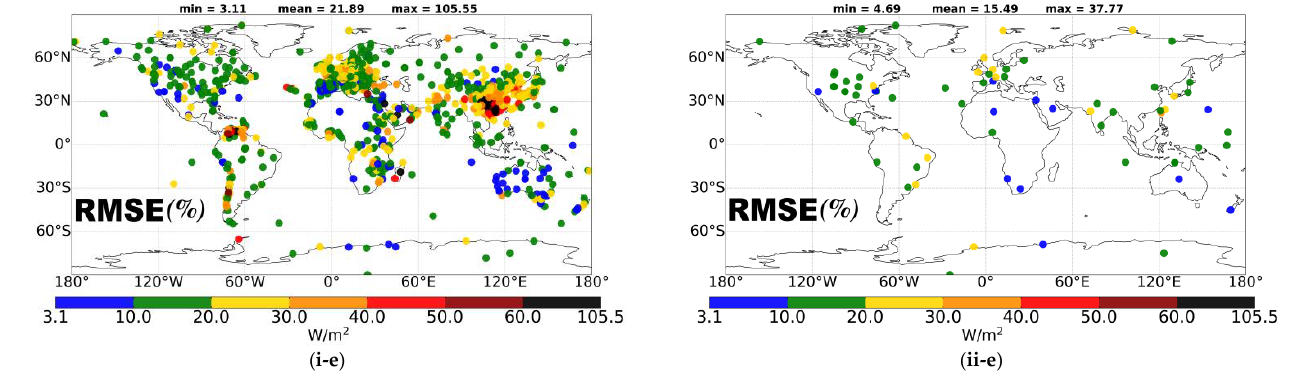
Figure 5. Global distribution of correlation coefficient ( i , ii-a ), bias ( i , ii-b ) and relative percent bias ( i , ii-c ) root mean squared error ( i , ii-d ), relative root mean squared error ( i , ii-e ), computed for the comparison between MERRA-2 and each GEBA (( i ), left column) and BSRN (( ii ), right column) station SSR fluxes, except for R that is computed using deseasonalized SSR anomalies. Large RMSE values are computed over tropical and sub-tropical regions,